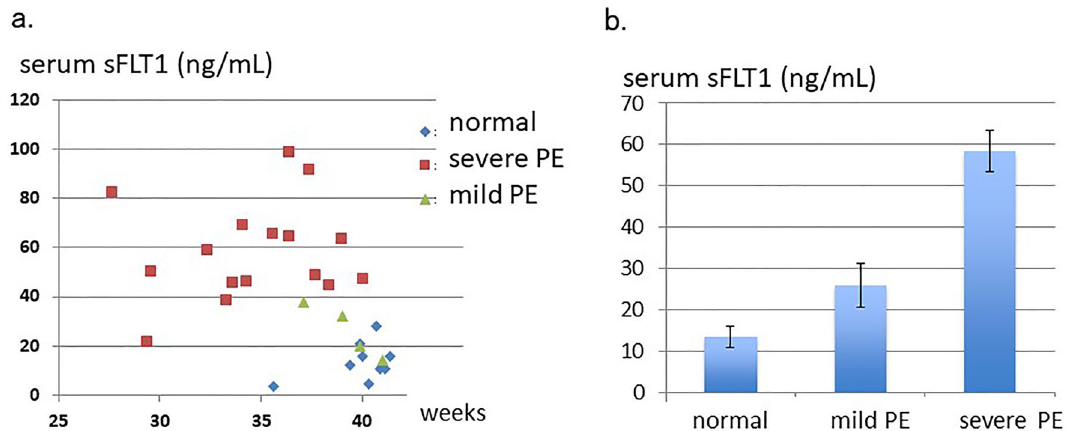
Figure 3. A significant increase in serum sFLT1 in severe PE cases. ( a ) sFLT1 levels (ng/mL) in serum samples detected with the HB-ELISA were shown with the time points when the serum sample was obtained (weeks: weeks of pregnancy). ( b ) The average values of sFLT1 in the serum samples from normal pregnancy, mild PE, and severe PE, are shown with SE. Increase in severe PE compared with the levels in normal pregnancy was statistically significant (p = 0.0016). The gestation weeks in the severe PE are 27w–5d to 40w–1d, the mild PE are 37w–1d to 41w–0d, and the normal pregnancy are 35w–4d to